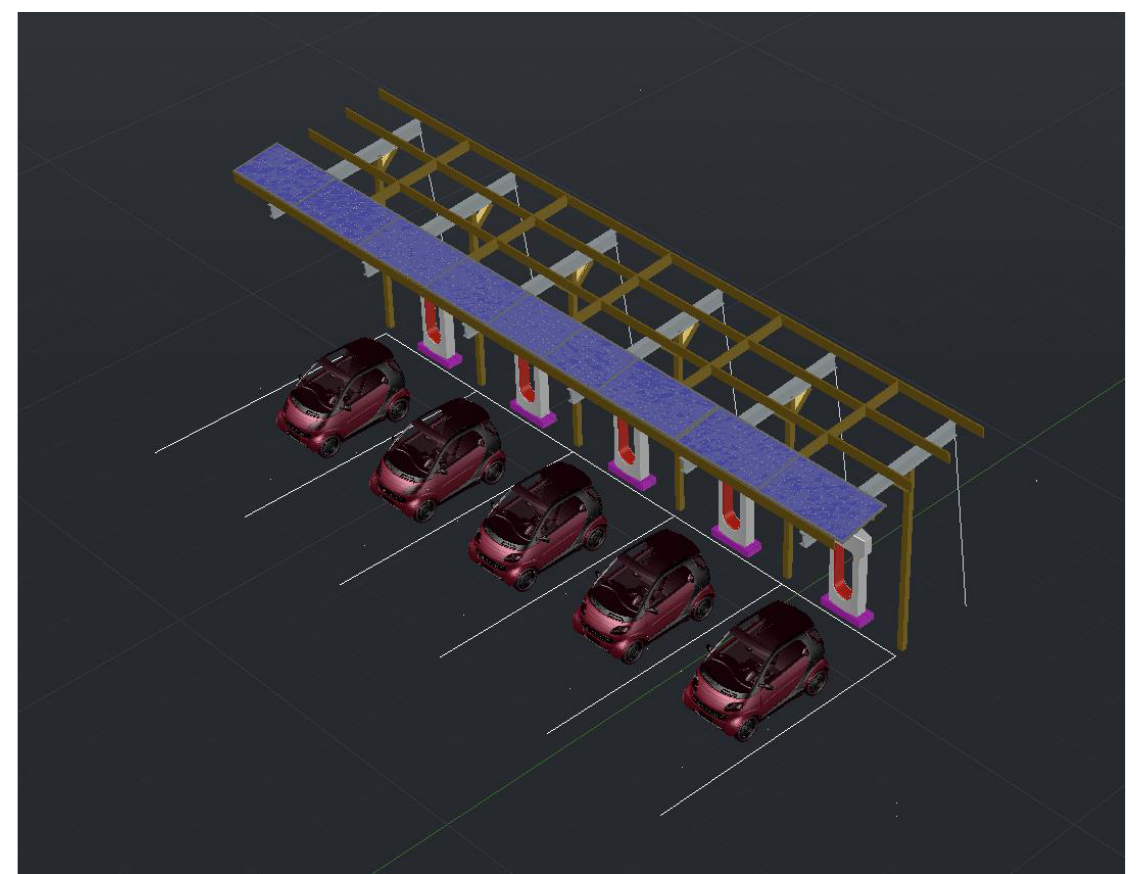
Figure 17. Cantilevered system reoriented for outsides of parking lots.